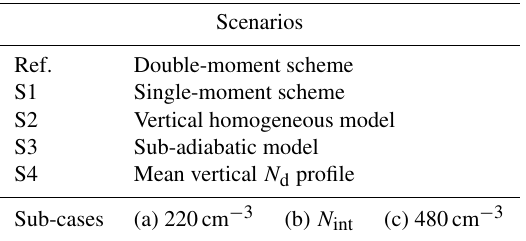
Table 6. Simulated scenarios. For scenarios S1–S3, three individual simulations (sub-cases) have been conducted according to different values for the droplet number concentration.